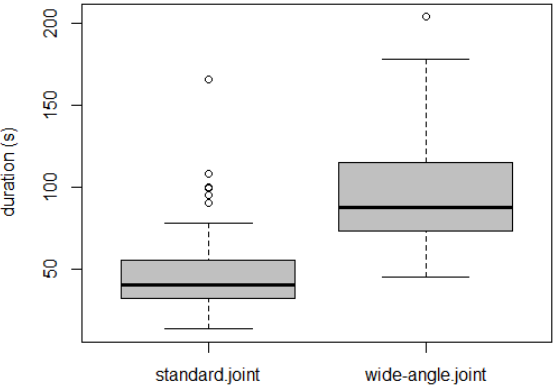
Figure 3. Duration of complete lubrication, differentiated by joint design; n (standard joint) = 50; n (wide-angle joint) = 16; outliers presented as circles. Table 1. Mean, maximum and minimum of the duration of a lubrication process in seconds as well as number of PTO shaft types.